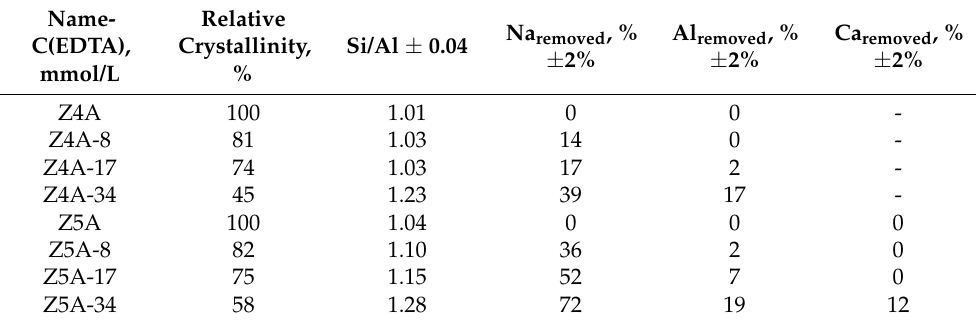
Table 1. Relative crystallinity, Si-to-Al ratio and fraction of removed Na, Al and Ca cations (deter- mined using EDX elemental analysis) from the parent zeolites 4A and 5A.